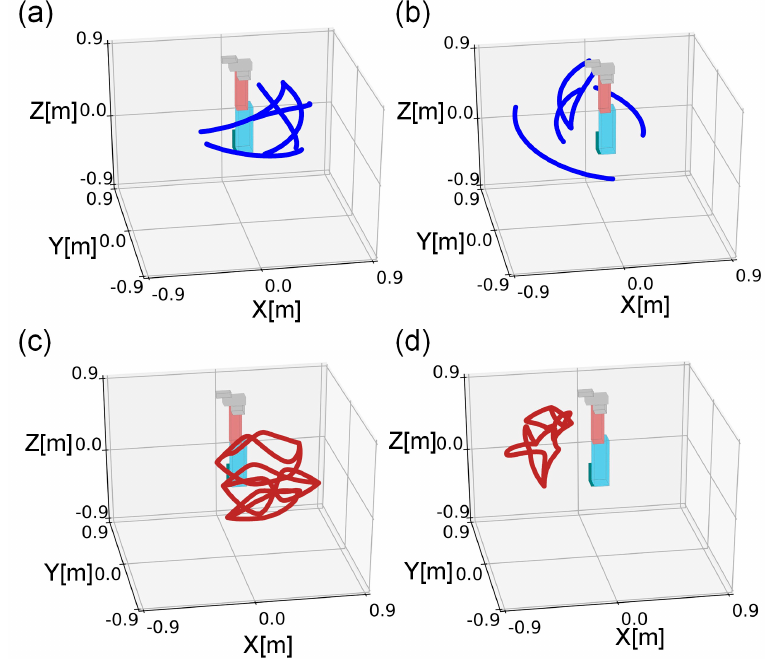
Figure 8. The trajectory data groups used for constructing the DNN model of the manipulator. The training trajectories T1 shown in ( a ) and T2 shown in ( b ). The evaluation trajectories E1 shown in ( c ) and E2 shown in ( d ).